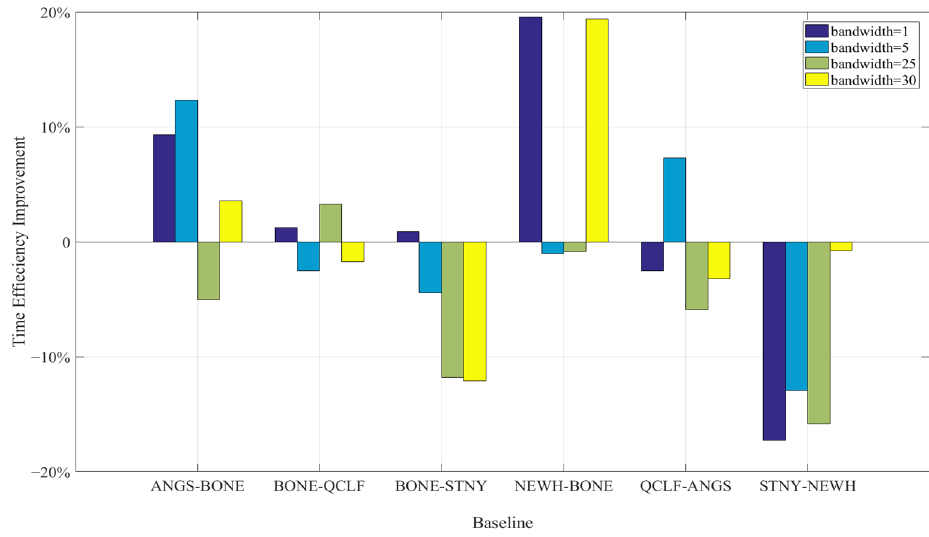
Figure 7. Time efficiency improvement for different KBW strategies.